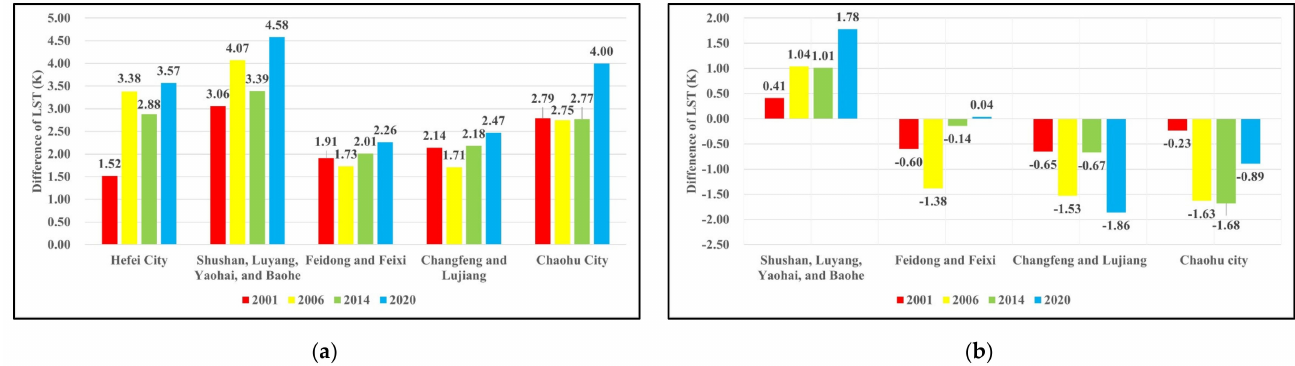
Figure 14. The difference of LST in 2001, 2006, 2014, and 2020 between: ( a ) urban and non-urban area; ( b ) four small research areas and the Hefei city in urban